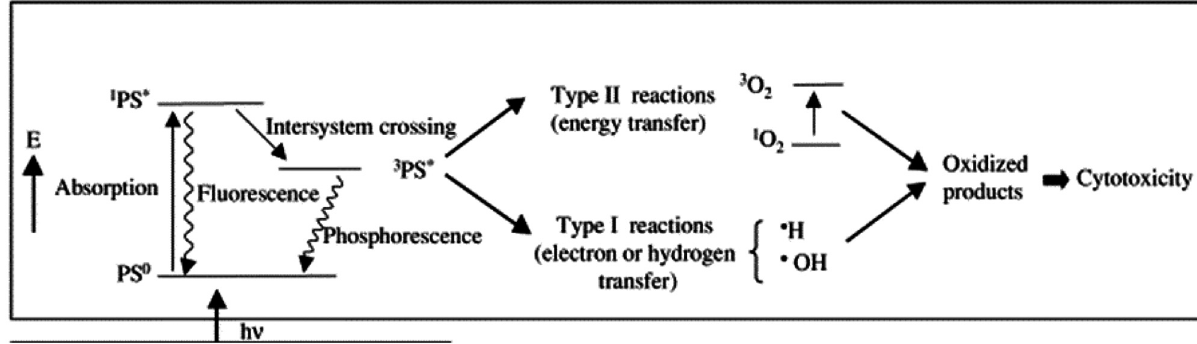
Figure 1: Photodynamic therapy (PDT) mechanism [14]. Copyright 2022 Elsevier publishing group.